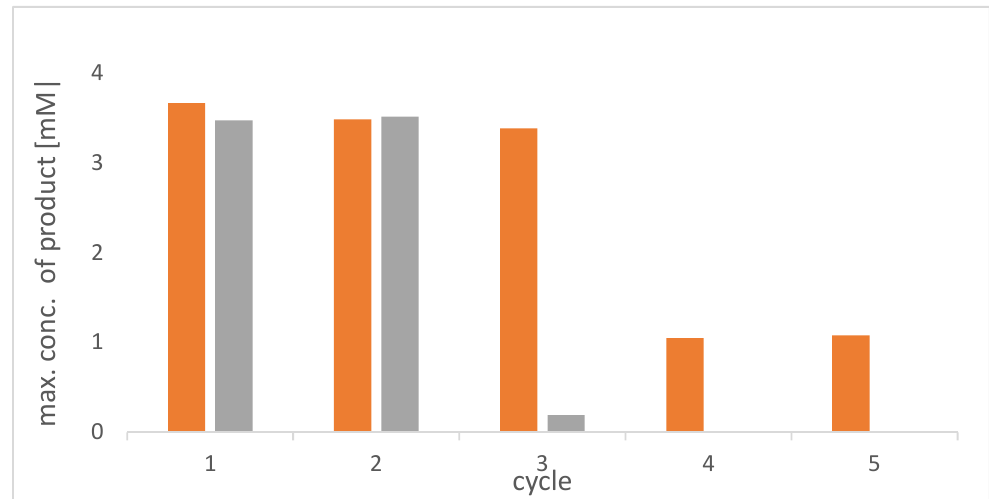
cycle Figure 2. Operational stability of viable cells E. coli with LK-ADH, XenB, and CHMO enzyme cascade entrapped in PEC beads (orange columns) and free cells (gray columns) during repeated cycles of model cascade reaction of 2-cyklohexen-1-ol to ε -caprolactone, depicted as the maximum achieved product concentration. Biotransformation conditions: temperature of 24 ◦ C, orbital shaking at 200